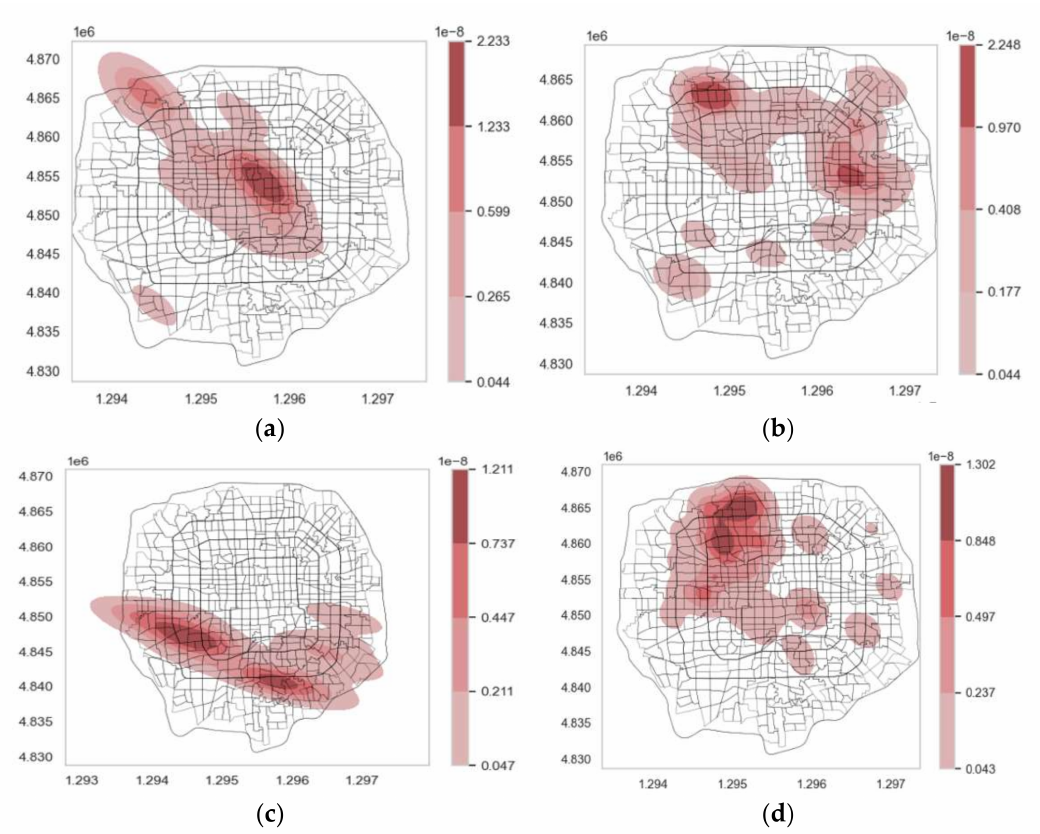
Figure 7. Intensity of representative kinds of POIs. ( a ) Intensity of toponymic address information, historical sites, scenic spots, cultural relics, and aquariums in cluster C1; ( b ) Intensity of business trade, corporate enterprises, restaurants, and bars in cluster C2; ( c ) Intensity of factories, industries, clothing, shoes, hats, and leather goods stores in cluster C7; ( d ) Intensity of science, education and cultural services, schools, and educational training institutions in cluster